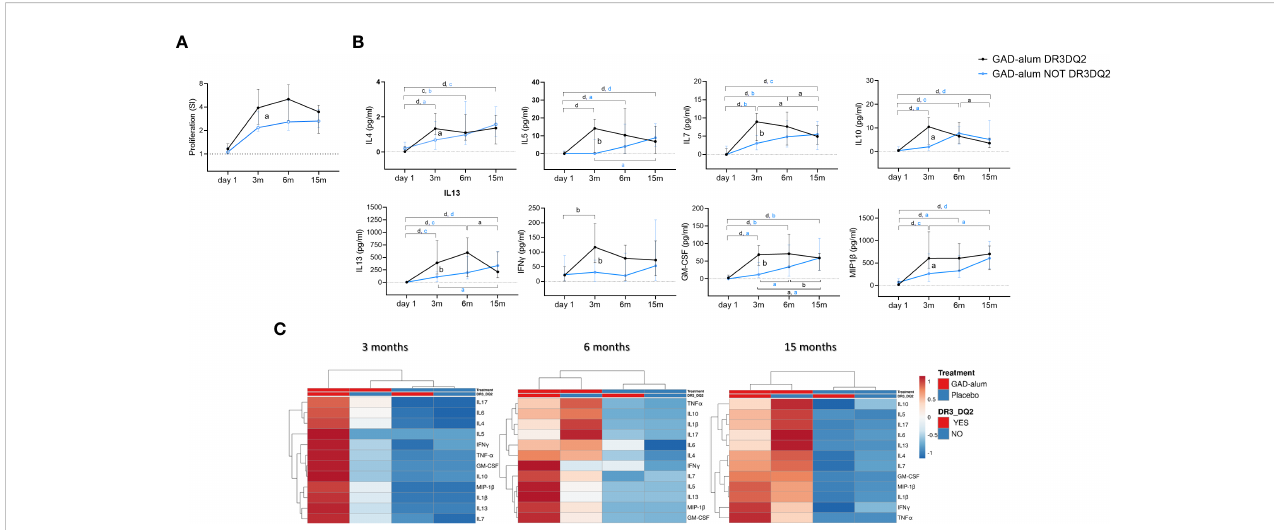
FIGURE 2 Immune response from day 1 to 15 months in GAD-alum treated patients with (black, n=29) and without (light blue, n=27) DR3DQ2 haplotype. (A) Median values of PBMC proliferative response to GAD 65 (5 µg/ml). Proliferation is expressed as stimulation index (SI), calculated from the mean of triplicates in the presence of GAD 65 divided by the mean of triplicates with medium alone. (B) Cytokine secretion detected by Luminex in PBMCs supernatants after 7-days culture in presence of GAD 65 (5 µg/ml). Median levels of IL4, IL5, IL7, IL10, IL13, IFN g , GM-CSF and MIP-1 b are given after subtraction of spontaneous secretion from each individual and expressed as pg/ml. Error bars indicate 95% CI. Differences within the same group were calculated using Wilcoxon paired test and differences between groups were calculated using Mann-Whitney unpaired test. a, b, c, d: p<0.05, p<0.01, p<0.001, p<0.0001. (C) Heatmap of cytokine secretion induced by GAD 65 (5 µg/ml) upon in vitro PMBCs stimulation of GAD-alum and Placebo treated patients. Columns with similar annotations (Treatment and DR3DQ2 haplotype) were collapsed by taking median inside each group. Both rows and columns are clustered using Euclidean distance and average linkage. Heatmap was performed using Clustvis software. Heatmap data matrix visualizes the values in the cells using a color gradient which gives an overview of the largest and smallest values in the